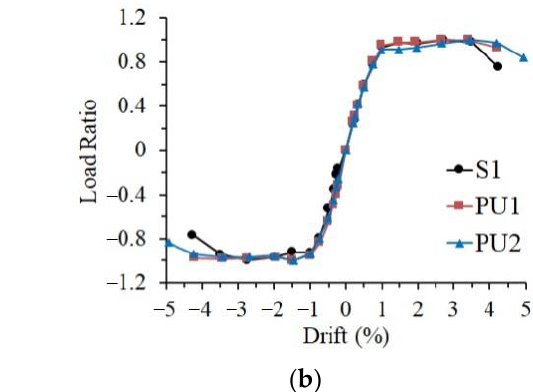
precast specimen remained relatively stable. This indicated that the UHPC shells helped to longer UHPC shells showed the best deformation capacity, reaching a loading drift of 5%.